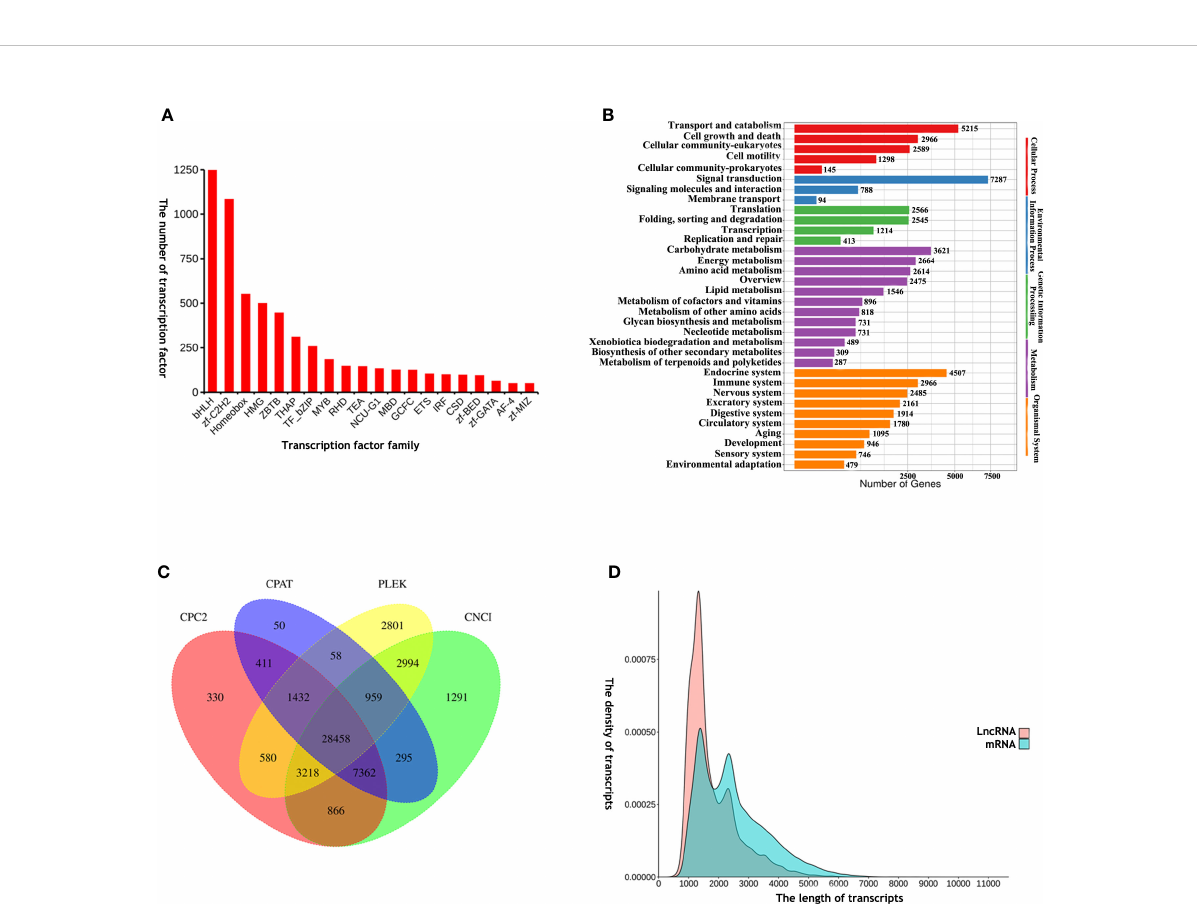
FIGURE 3 (A) The top 20 TFs: basic helix-loop-helix (bHLH), zinc fi nger C2H2 (zf-C2H2), homeobox, high-mobility-group (HMG), Zinc fi nger and BTB domain containing (ZBTB), thanatos associated protein (THAP), TF_basic region-leucine zipper (TF_bZIP), v-myb avian myeloblastosis viral oncogene homolog (MYB), Rel homology domain (RHD), TEA domain transcription factor (TEA), Lysosomal transcription factor (NCU-G1), methyl-CpG-binding domain (MBD), GC-rich sequence DNA-binding factor homolog (GCFC), E26 transformation-speci fi c (ETS), interferon regulatory factor (IRF), cold-shock domain (CSD), BED-type zinc fi nger domain (zf-BED), GATA zinc fi ngers (zf-GATA), AF4/FMR2 family (AF-4), MIZ-type zinc fi nger domain (zf-MIZ). The x-axis shows different types of TFs and the y-axis shows the number of TFs; (B) KEGG analysis annotation of miRNA-targeted genes obtained, as determined by online miRanda software prediction; (C) Venn diagram of lncRNA analysis results; (D) Length distribution density analysis of annotated lncRNAs and mRNAs. The x-axis and y-axis represent the length and density of transcripts,